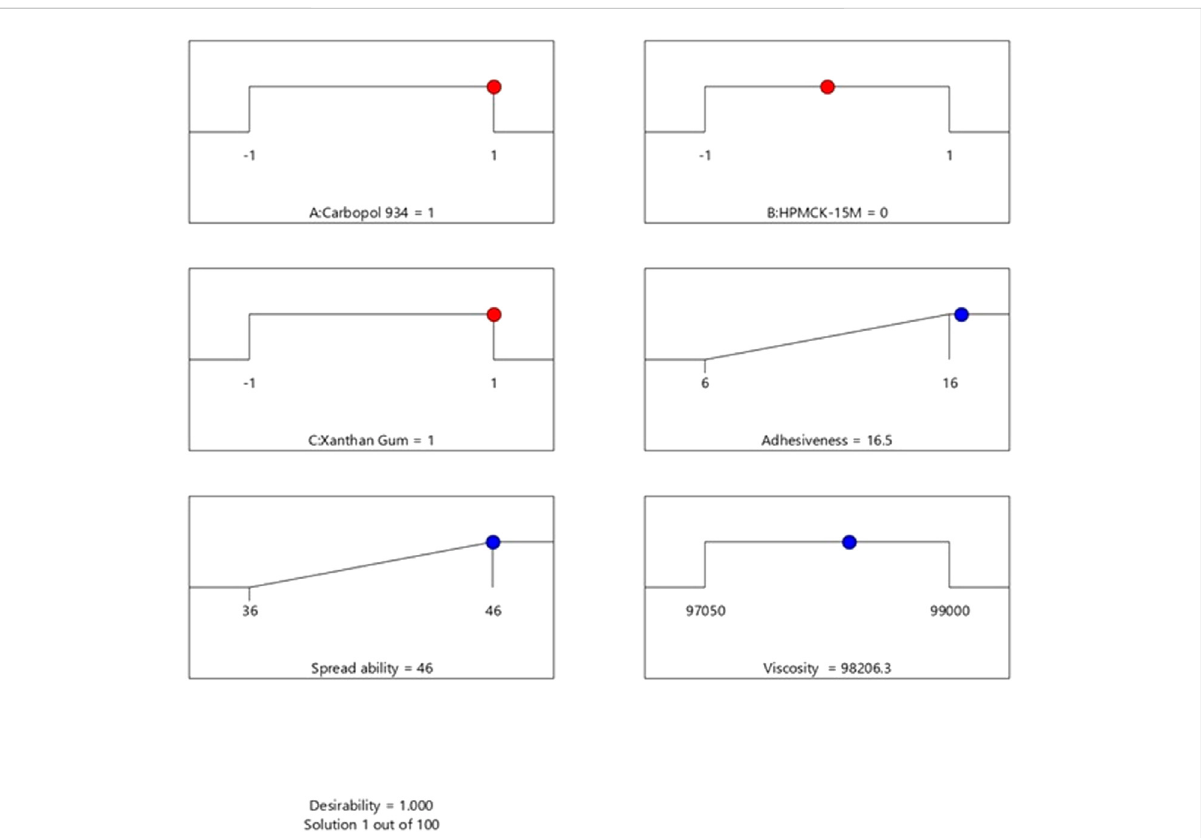
FIGURE 1 Optimization of the formulation by using Design Expert version 12. The analysis predicted 100 solutions for assessing and predicting the best formulationgroup.Thesolutionwithadesirabilityvalueof1indicatedthatanincreaseintheconcentrationofCarbopol934andxanthangumwould increase the spreadability and adhesiveness of the product along with the